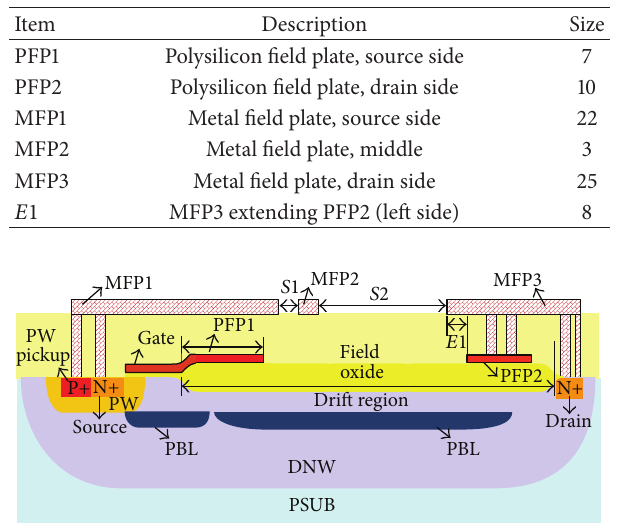
Table 1: Key reference sizes of this NLDMOS.